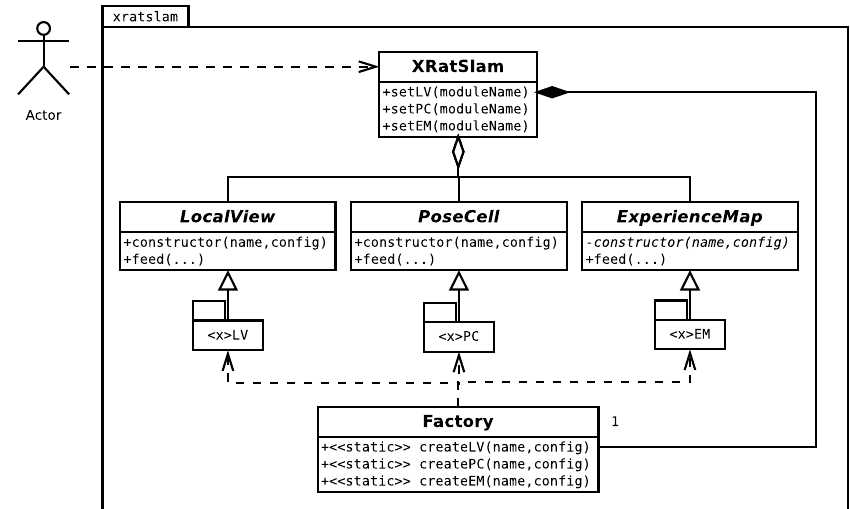
Figure 4. xRatSLAM class diagram highlighting factory project aspects. The Factory design pattern allows for dynamically instantiating each specific module implementation based on its respective name by knowing internal module packages independently of package implementations. Note that the system uses just one Factory element. Used symbols follow standard